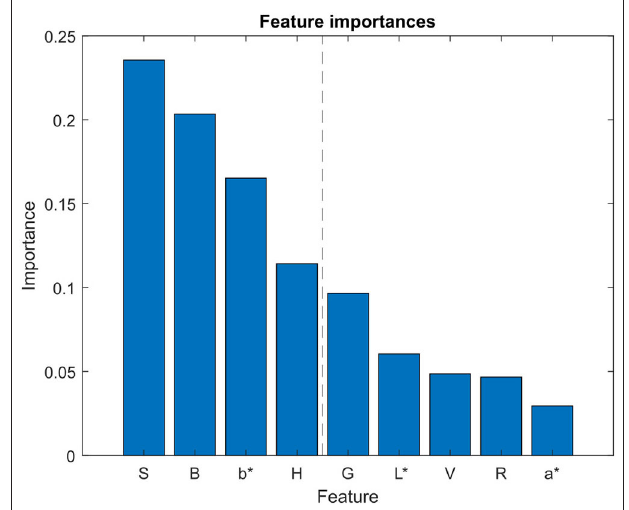
FIGURE 5 | Individual plot image preprocessing results, (A) Raw RGB image extracted from the orthomosaic map, (B) Preprocessing results for the same plot image after removing vegetation pixels using the ExGR mod index (Equation 1), (C) Preprocessing results for the same plot image after removing also bare soil pixels using the Soil Idx index (Equation 2), (D) Binary mask used for SVM pixel classifier training. White color identifies cotton pixels. Black color identifies non-cotton pixels.